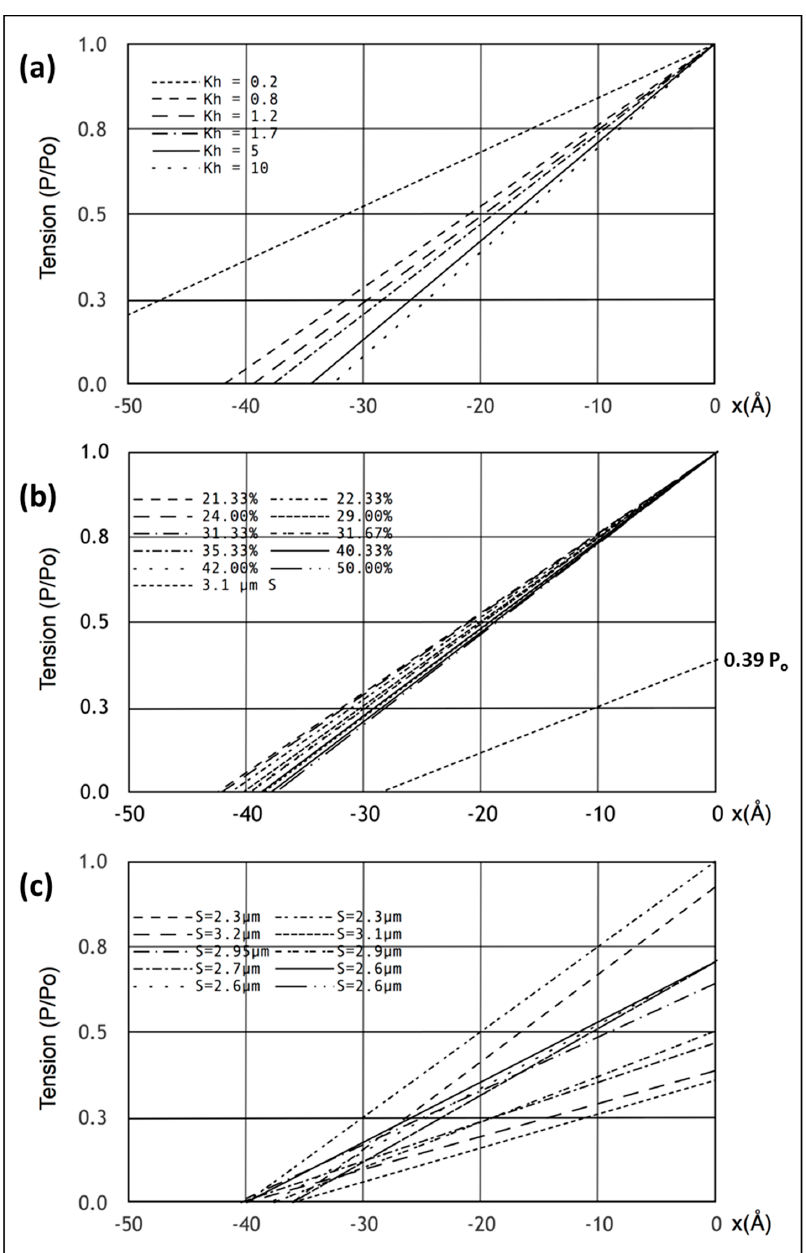
Figure 5. ( a ) T 1 plots showing the position of the T 1 intercept on the x axis for zero tension as a function of the myosin head stiffness in Model 3 for a muscle at full overlap . ( b ) Similar to ( a ) but here for different percentage cross-bridge attachments to actin at full overlap and also what happens at 3.1 µm sarcomere length (tension 0.39 P o ) using Model 3. ( c ) The observations of Ford et al. [4] plotted here assuming purely linear elasticities and assuming that tension varies linearly with overlap, shown for comparison with ( a ) and ( b ).